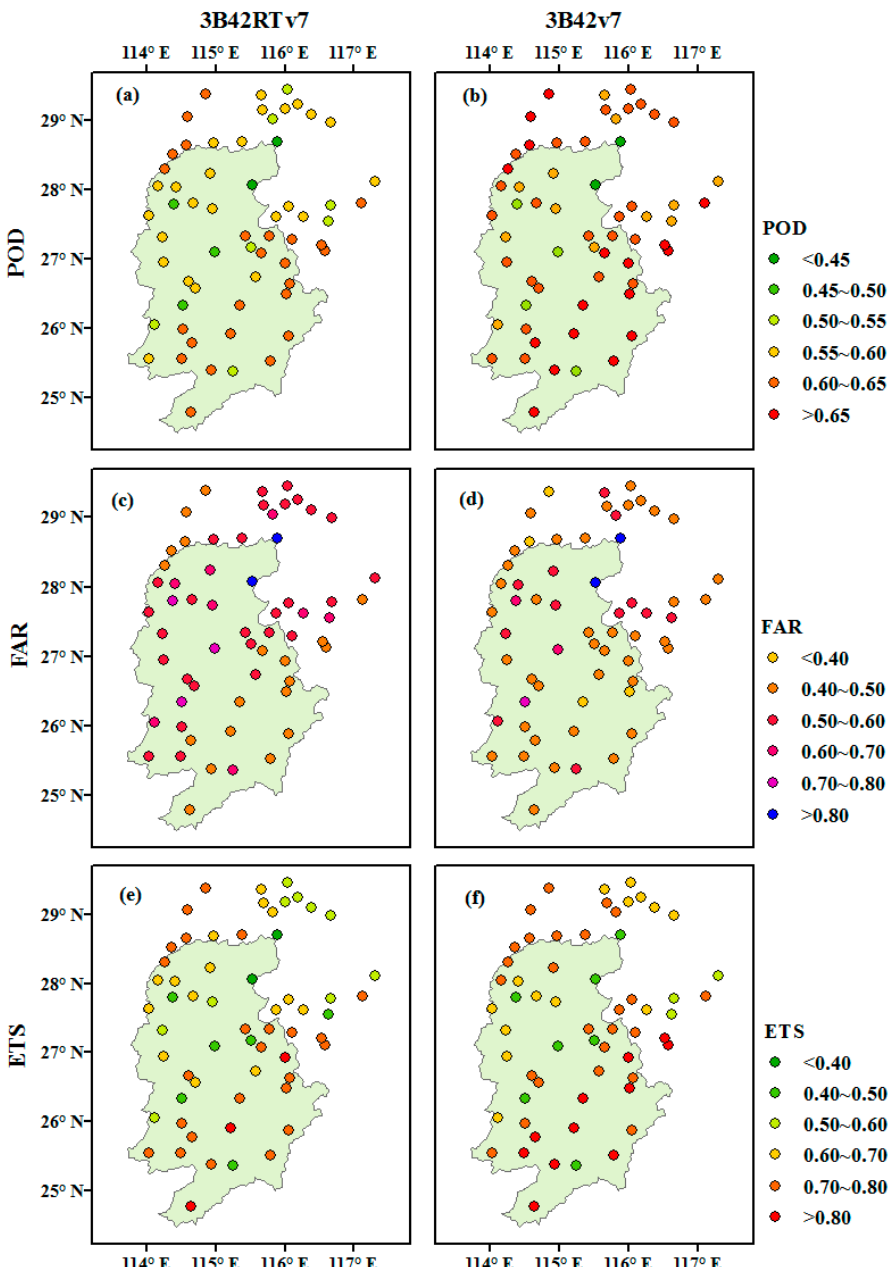
Figure 4. Spatial distributions of ( a, b ) Probability of Detection (POD), ( c, d ) False Alarm Ratio (FAR), and ( e, f ) Equitable Threat Score (ETS) for 3B42RTv7 (the first column) and 3B42v7 (the second column) at a daily scale over the Ganjiang River basin for the 14-year study period (January 2000 to December 2013). The space-averaged daily precipitation series keeps good consistency between the SPE and ground-based precipitation. The values of pairwise correlation, r , between three datasets were relatively high (greater than 0.88). In general, the performance of 3B42RTv7 and 3B42v7 products suggested by the Probability Density Function (PDF) of daily precipitation in Figure 5 was acceptable, compared to the gauge-based precipitation. The primary differences between the PDFs of SPE and gauge-based reference arose from the lower ends of precipitation intensity bins, where 3B42RTv7 and